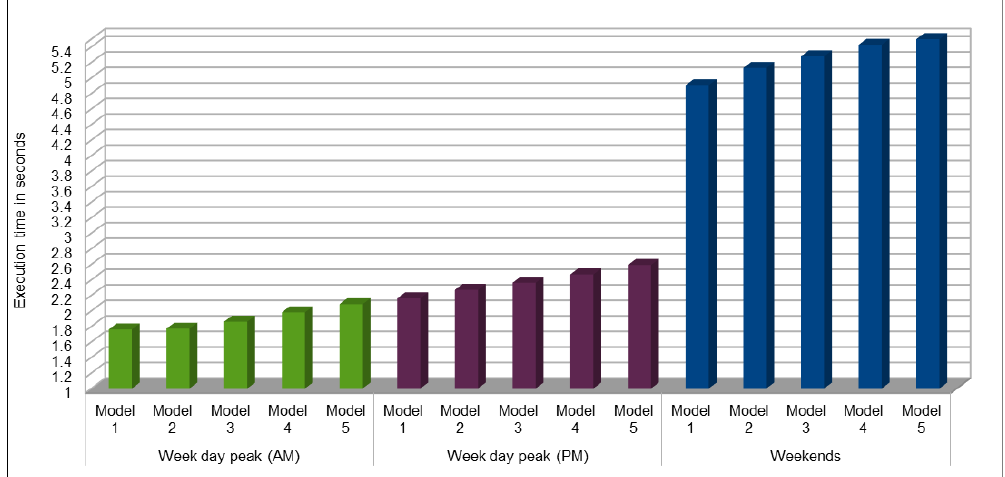
Figure 23. Model execution time while making predictions using the pre-trained models.